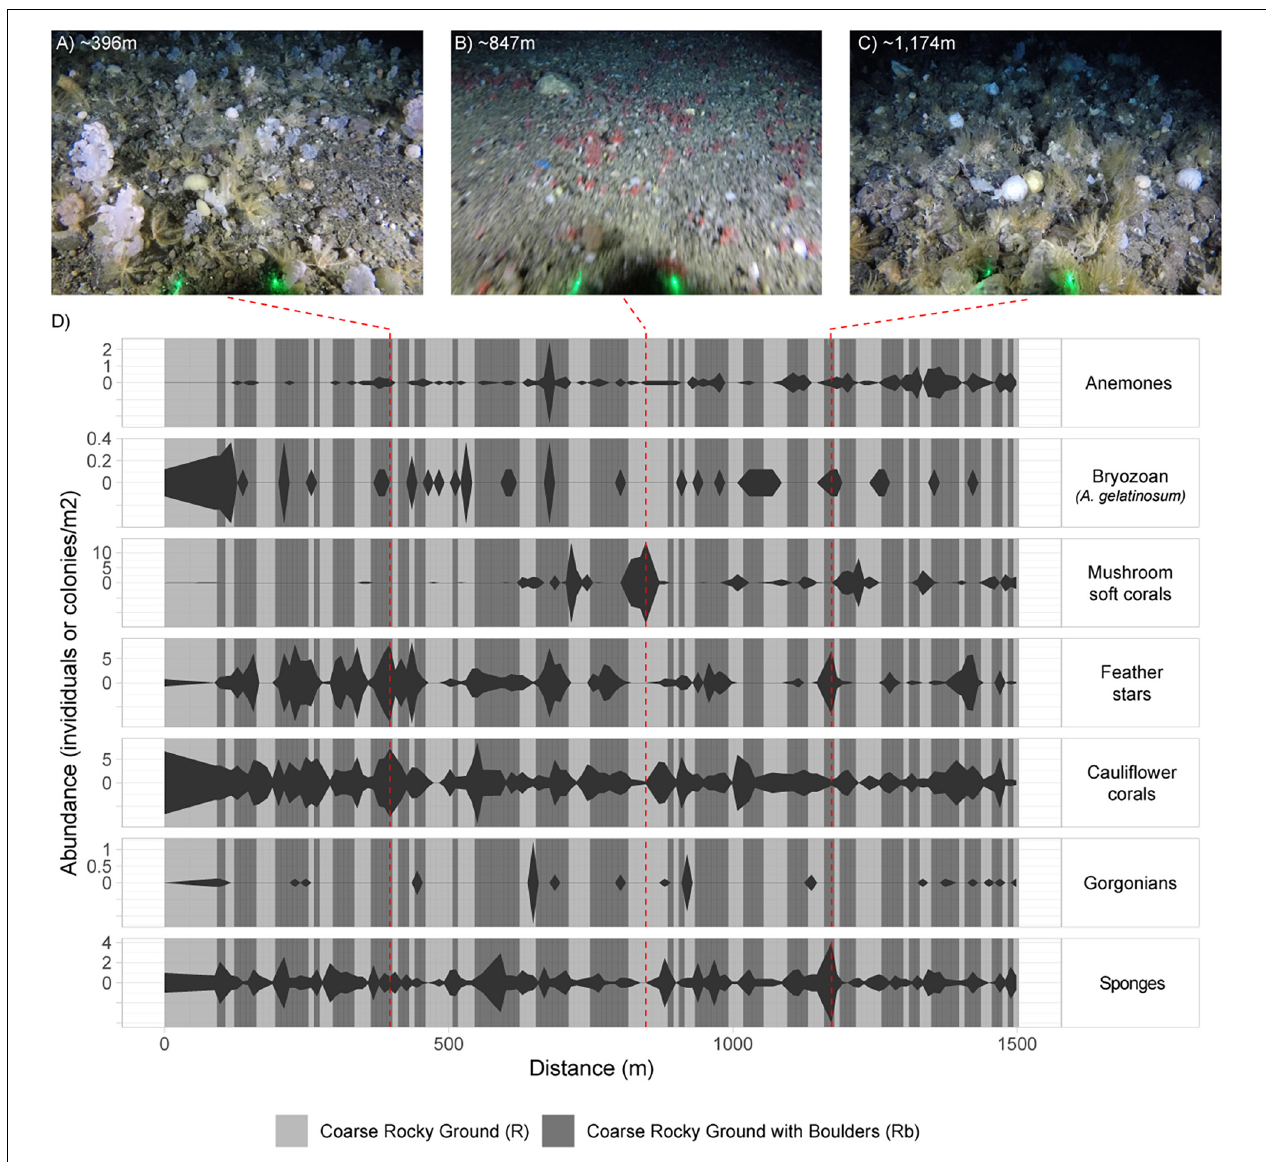
FIGURE 5 | Kite diagram showing variation in faunal abundance and substrate across an example station (2018_SA_11_087), based on fauna and substrate annotations of images sampled from the video. The width of kite is determined by the observed abundance in the image sampled at that distance along the tow. Distance is based on the speed of the vessel and the time elapsed from touchdown. The background is shaded according to substrate observed in each image. Substrate type and faunal abundance is interpolated between images to produce an illustrative representation. The example images (A–C) are included to illustrate the variation across the station as described by (D) . The left and right extremities of example images have been cropped and thus do not display the full field of view (FOV). Laser dots (green) are 20 cm